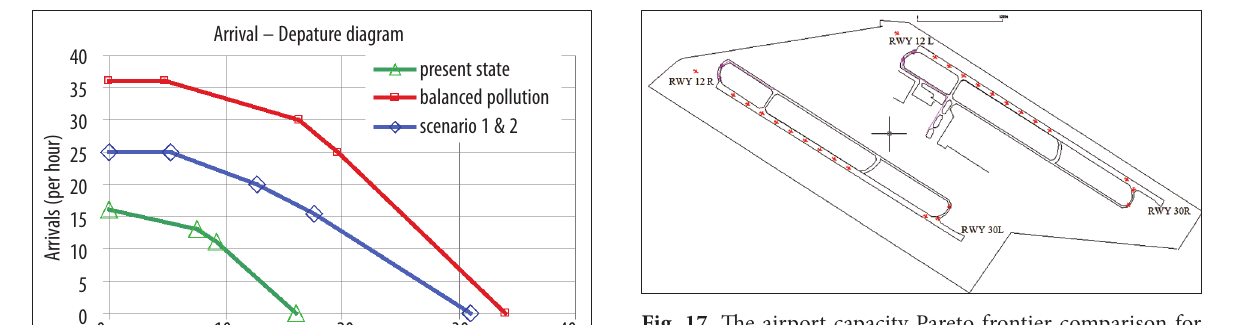
Fig. 17. The airport capacity Pareto frontier comparison for different traffic assignment scenarios